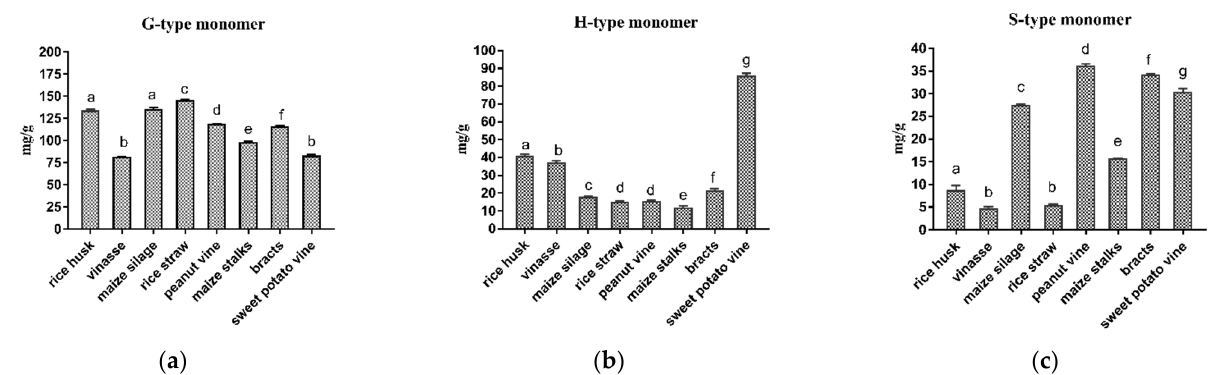
Figure 1. ( a ) The content of G-type monomer in 8 kinds of roughage; ( b ) the content of H-type monomer in 8 kinds of roughage; ( c ) the content of S-type monomer in 8 kinds of roughage. G means coniferyl alcohol; H means ρ -coumaryl alcohol; S means sinapyl alcohol. The different letters on the top means significant difference ( p < 0.05); the same letters mean no significant difference ( p > 0.05).